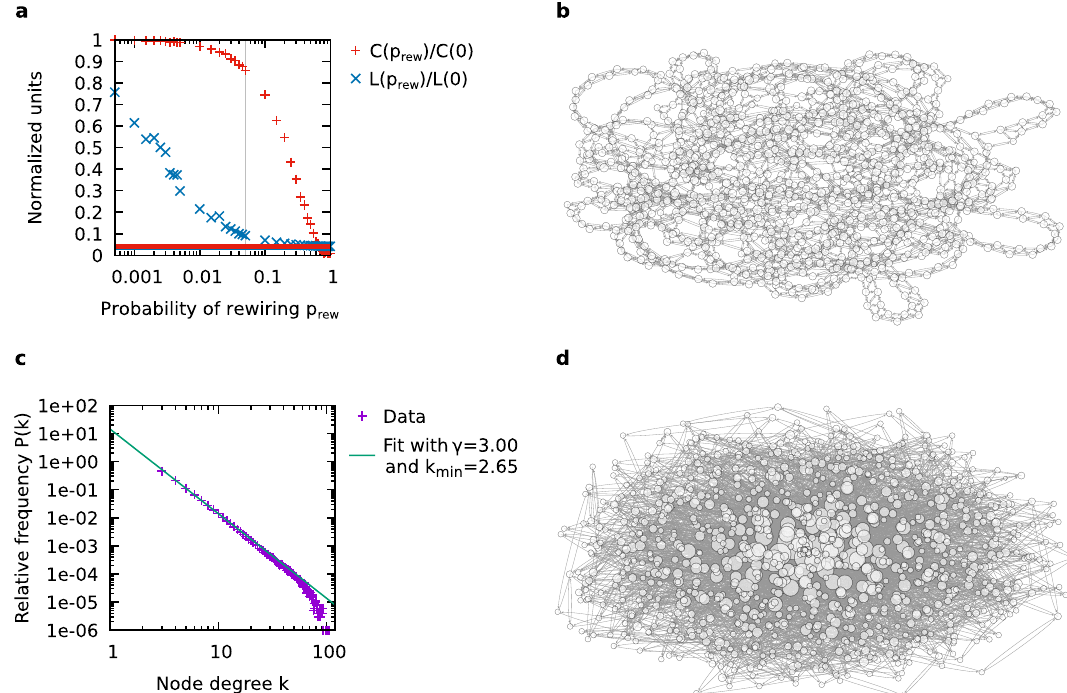
Figure 1. Generated small-world and scale-free networks. ( a ) Transition from regular to random topology: Watts–Strogatz clustering coefficient C and average shortest-path length L of small-world networks with 1000 and varied rewiring ratio. Both quantities are normalized with respect to the value for a regular N = 0 , where the Watts–Strogatz clustering coefficient is 0.500 and the average shortest path network (i.e., p rew = length is 125.44). The dashed red and solid blue lines indicate, for comparison, the values of C and L for the 1000 and p rew 0.05 (Watts– scale-free network shown in ( d ). ( b ) Sample small-world network with N = = Strogatz clustering coefficient: 0.429, average shortest path length: 11.42). ( c ) Degree distribution of scale-free 0 , and m 1000 , m 0 2 (averaged over 1000 trials). The green line shows a fit function networks with N = = = 5 were considered. See the main text for a discussion. ( d ) as given by Eq. (10). For fitting, all values with k ≥ 1000 (Watts–Strogatz clustering coefficient: 0.021, average shortest path Sample scale-free network of N = length: 4.33; also cf. ( a )). Nodes in ( b ) and ( d ) are represented by circles and node degree is indicated by circle size. Arrows represent links between nodes. Self-coupling of nodes has been masked for better